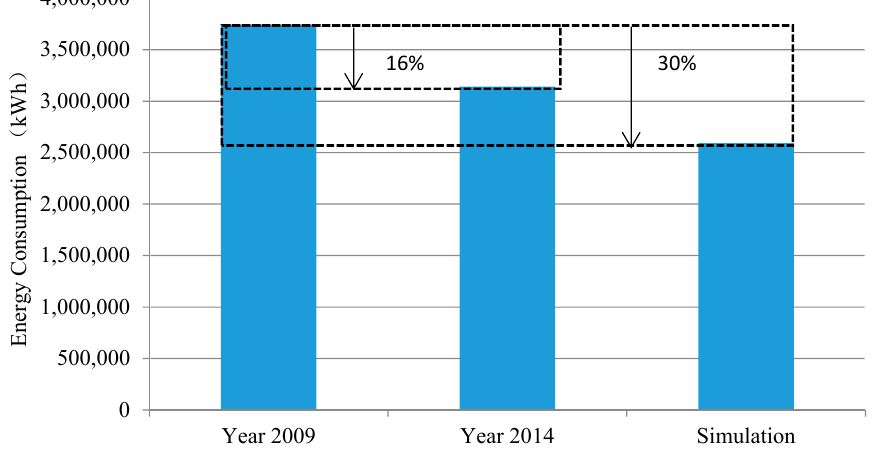
Figure 13. Total electricity use in the year 2009, 2014 and the simulation result.